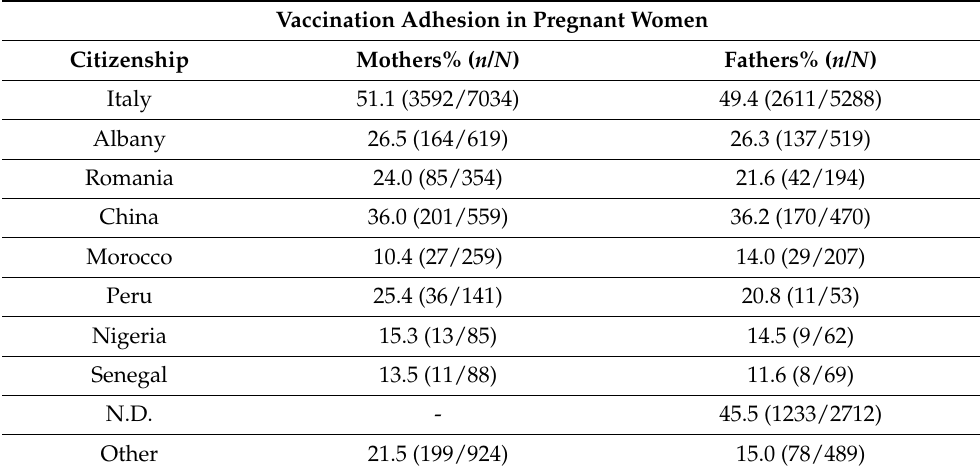
Table 2. Tdap vaccination adhesion in pregnant women by mothers’ and fathers’